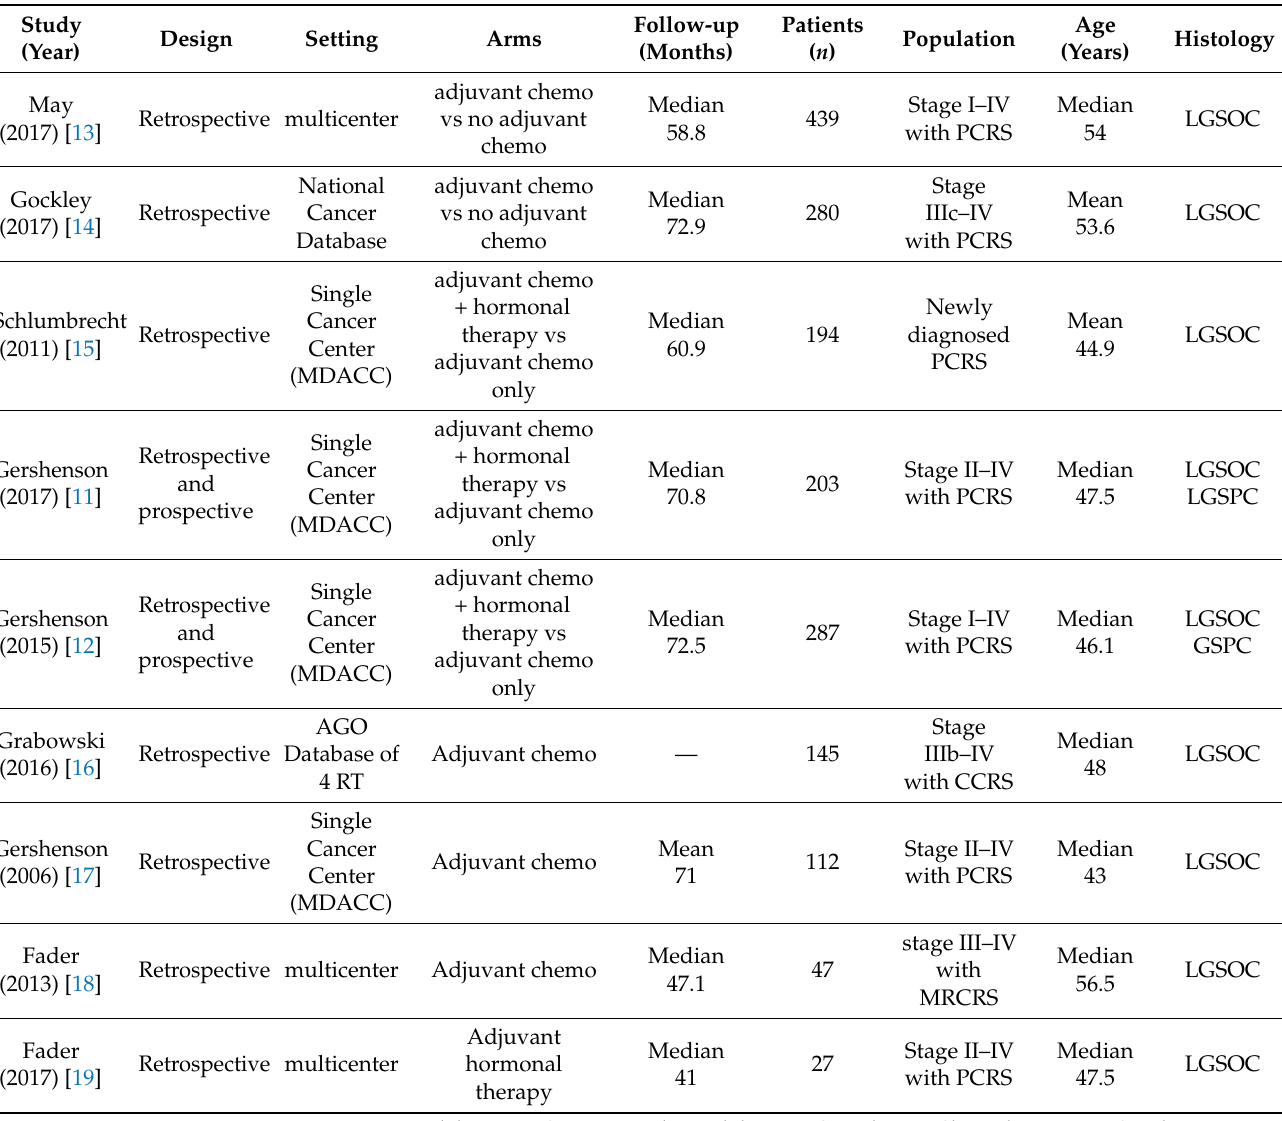
Table 1. Summary of the baseline characteristics of the nine included studies for the first-line setting (primary